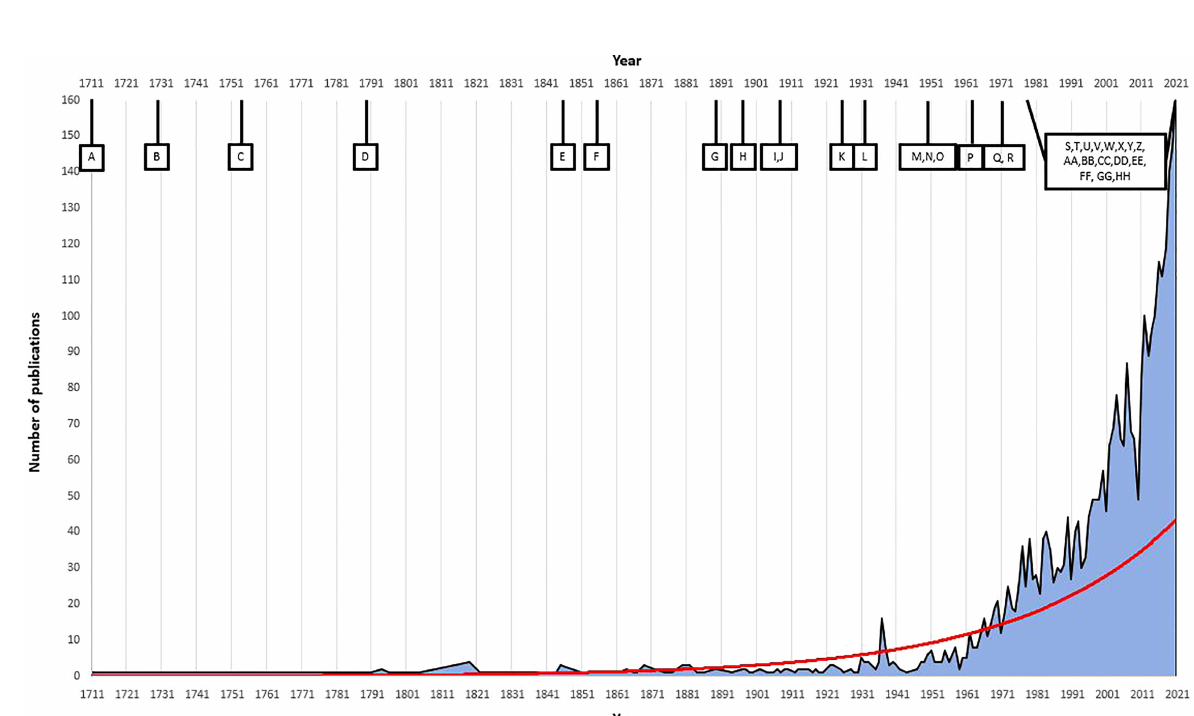
FIGURE 2 Correlation of number of Fucus publications and key advances in Fucus reproduction/research and general technological advancements over time. We used the software Dimensions (Digital Science; https://app.dimensions.ai/discover/publication) to search for ‘ Fucus ’ in titles and abstracts of all journals and all dates. Red line is the exponential trendline based on the number of publications released. (A) 1711, fi rst publication on Fucus reproduction (Re ́ aumur 1711); (B) 1730, advancement in microscope technology (Tromp, 2015), (C) 1753, fi rst taxonomic description of Fucus Linnaeus (Linne ı ́ and Salvius, 1753); (D) 1790-1900, early chemical, physiological and biological descriptions (Woodward, 1791; Stackhouse, 1801; Kniep, 1925); (E) 1845, initial research on life history, reproductive methods and taxonomy reassignment (Genus Fucus ) (Decaisne & Thuret, 1845); (F) 1854, fi rst description of fertilisation in Fucus and fi rst cross-experiments (Thuret, 1855); (G) 1890, beginning of laboratory cultures (Campbell, 1889); (H) 1897, fi rst cytological study of Fucus (Farmer & Williams, 1897); (I) 1909, fi rst observation of fertalisation and total number of chromosomes (Yamanouchi, 1909); (J) 1909, early ecological studies (Baker, 1909; Baker, 1910); (K) 1925, fi rst successful cross experiments (Kniep, 1925); (L) 1931, invention of the electron microscope (Freundlich, 1963); (M) 1950, fi rst electron microscope image of Fucus (Manton & Clarke, 1950); (N) 1950, beginning of autocological research in Fucus (Knight & Parke, 1950; Burrows & Lodge, 1951); (O) 1951, natural hybridization experiment (Burrows & Lodge, 1951); (P) 1962, further studies on Fucus chromosome number (Evans, 1962); (Q) 1970, detailed experimentation on gamete release and gamete physiological structure and characteristics for Fucus (Pollock, 1970); (R) 1970-1995, in-depth research on individual, population and community ecology in Fucus (Chapman, 1995); (S) 1977, fi rst generation sequencing (Heather & Chain, 2016); (T) 1979, detailed investigation on natural morphological variation and phenotic plasticity in Fucus (Scott & Hardy, 1994); (U) 1980, formal demographic analysis on Fucus species (Gunnill, 1980); (V) 1970-1990, development of PCR and microsatellites (Kaunitz, 2015; Saeed et al., 2016); (W) 1985, discovery of pheromonal gamete attraction in Fucus (Müller & Gassmann, 1985); (X) 1980-1991, comprehensive studies on egg production in Fucus (Vernet & Harper, 1980; Robertson, 1987; Ang, 1991); (Y) ~1990, detailed research in rates of reproduction, settlement, recruitment and population modelling in Fucus begun (Chapman, 1995); (Z) 1997-1999, rDNA and nrDNA sequencing of internal transcribed spacer region in Fucus and SSU and LSU sequences (Leclerc et al., 1998; Rousseau et al., 1997; Rousseau & de Reviers, 1999; Serrão et al., 1999a); (AA) 2002-2003, design of polymorphic microsatellite markers for Fucus (Coyer et al., 2002c; Engel et al., 2003); (BB) 2005, next generation sequencing begun (Heather & Chain, 2016); (CC) 2006, RNA extraction method designed for Fucus and tested with RT-PCR, RNA- labelling and Northern analysis methods (Pearson et al., 2006), (DD) 2006, complete mitochondrial genome for F . vesiculosus and mtDNA- based phylogeny showing the two Fucus lineages (Oudot-Le Secq et al., 2006; Coyer et al., 2006a); (EE) 2011, third generation sequencing (Heather and Chain, 2016); (FF) 2013, fi rst investigation in sex-biased gene expression in F . vesiculosus (Martins et al., 2013); (GG) 2013-present, effects of climate change on Fucus distribution (Jueterbock et al., 2014; Rothäusler et al., 2018; Rugiu et al., 2018; Rothäusler et al., 2019); (HH) 2020-to present, complete annotated genome and transcriptome using illumina and nanopore platforms (https://phaeoexplorer.sb-roscoff.fr/